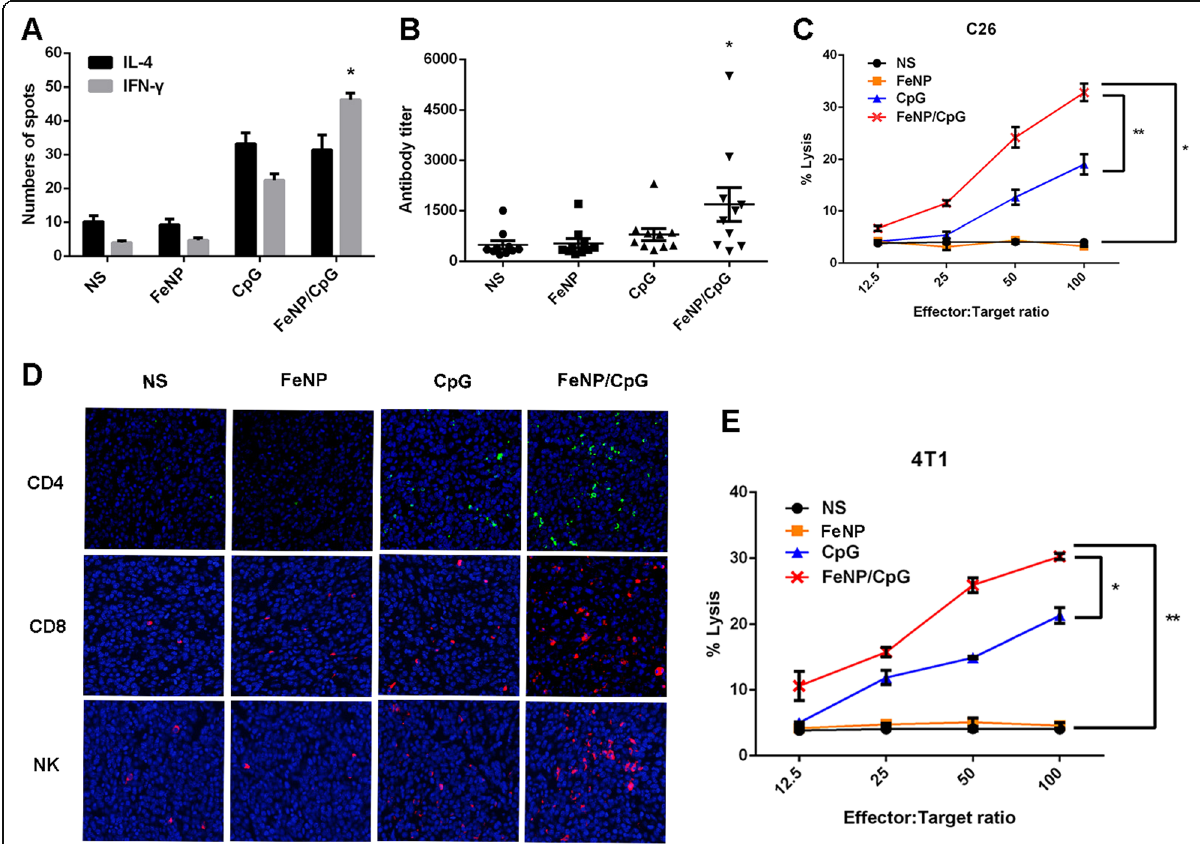
Fig. 5 The mechanism of antitumor immune response. a ELISpot assay. Splenocytes were harvested from NS or treated mice after the final treatment, and ELISpot assays were performed using the mice IFN- γ /IL-4 Dual-Color ELISpot kit in the C26 xenograft model. b In the C26 model, serum antibody titers in tumor-bearing mice treated by FeNP/CpG particles were tested using an ELISA assay. Each symbol represents an individual mouse, and horizontal lines indicate the median as determined by Mann – Whitney U tests. c CTL assays. The cytotoxicity of splenocytes against C26 cells were examined in a 4-h 51Cr-release assay. d Representative immunofluorescence images showing infiltrating immune cells in tumor tissues in each group. The FeNP/CpG particles treatment groups with enhanced CD4 + T, CD8 + T and NK (CD57 + ) cell infiltration in tumors compared to that of other groups. e The cytotoxicity of splenocytes against 4T1 cells were examined in a 4-h 51Cr-release